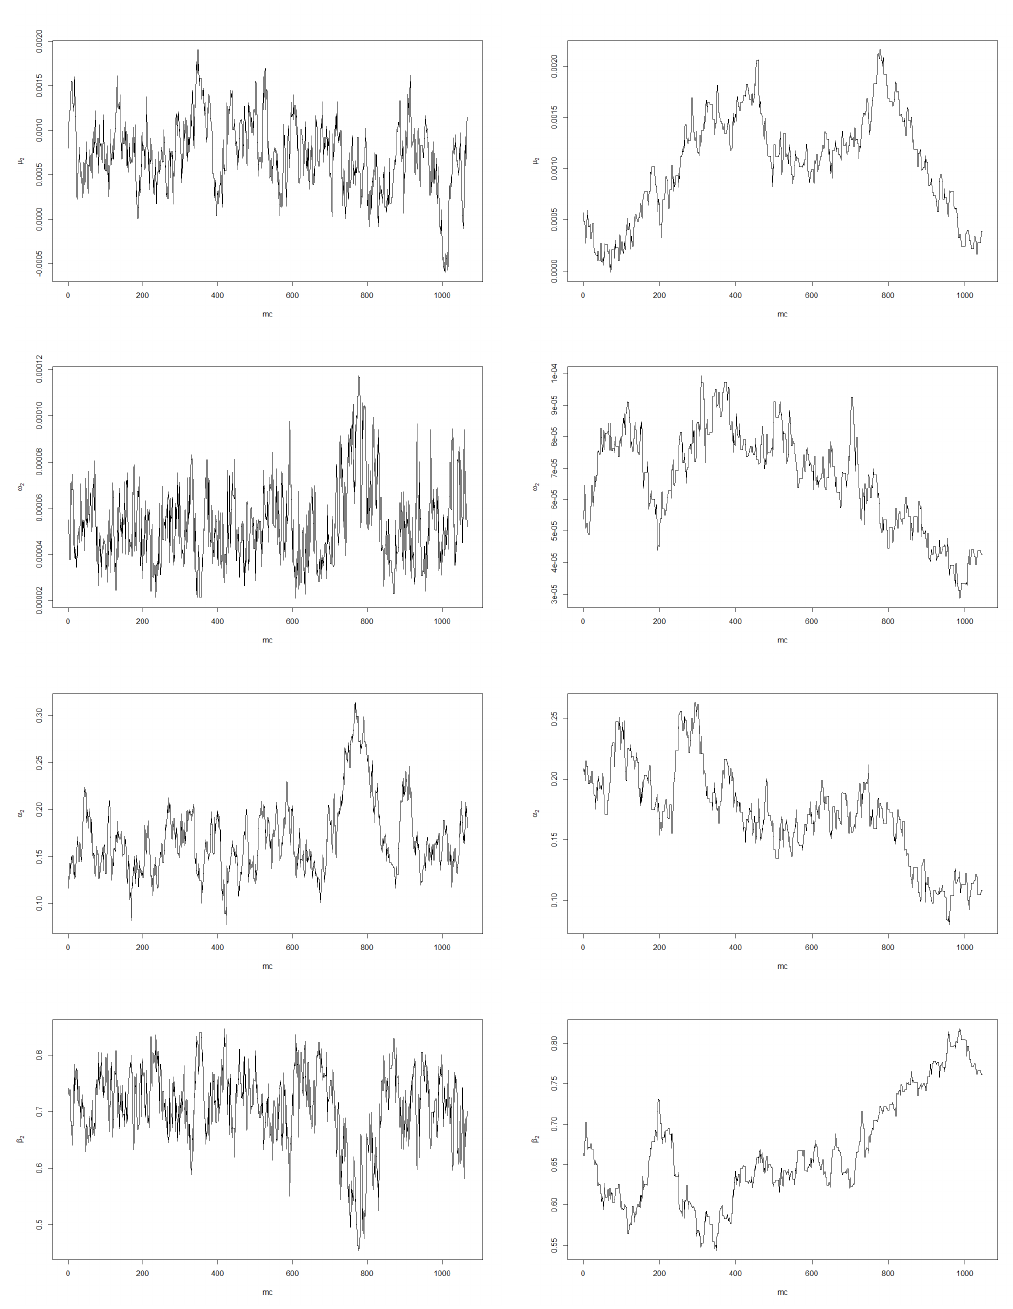
Figure 5: Chains of parameter draws for µ 2 , ω 2 , α 2 , and β 2 ; CHMC (left) and RW-MCMC